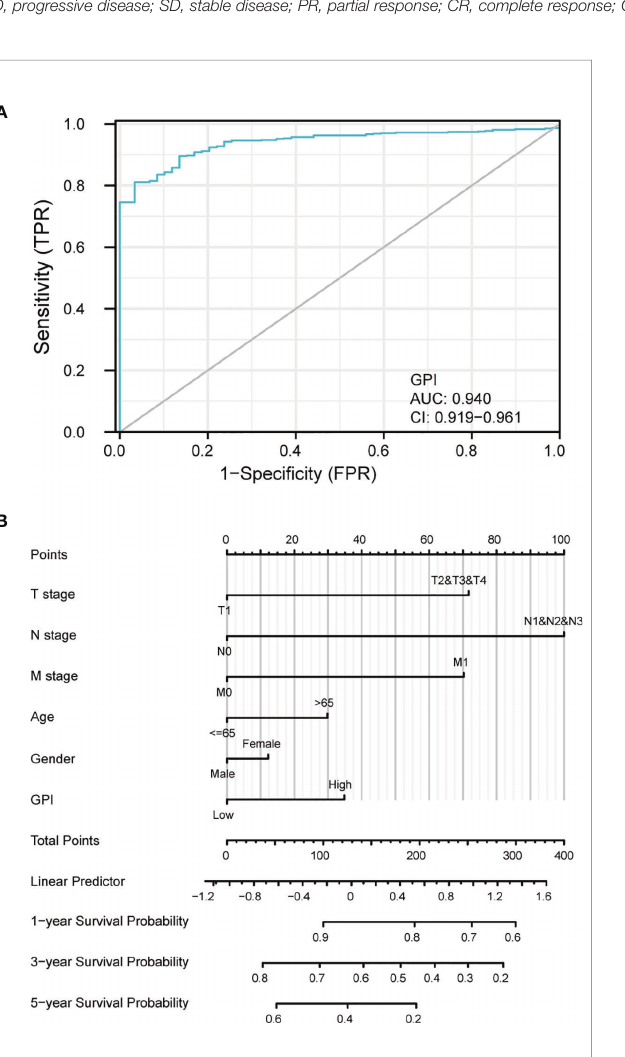
FIGURE 6 | Diagnostic value of glucose-6-phosphate isomerase (GPI) expression in lung adenocarcinoma (LUAD). (A) Receiver operating characteristic (ROC) curve analysis for GPI expression in LUAD and adjacent tissue. (B) Nomogram survival prediction chart for predicting the 1-, 3-, and 5-year overall survival